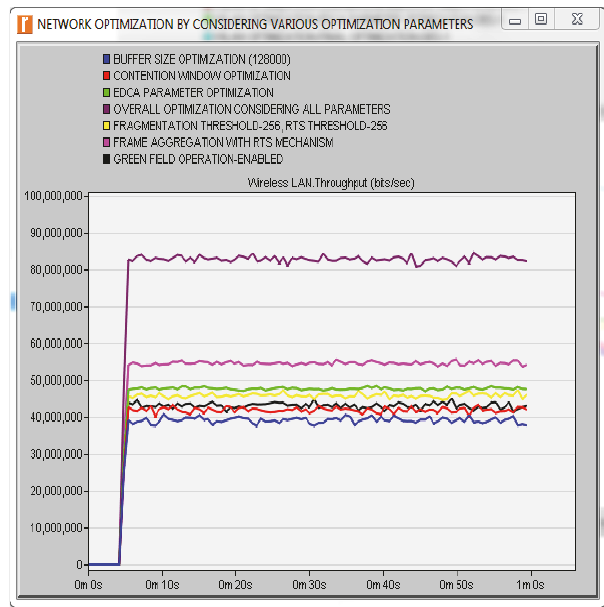
Figure 43: Network optimization by considering various parame-